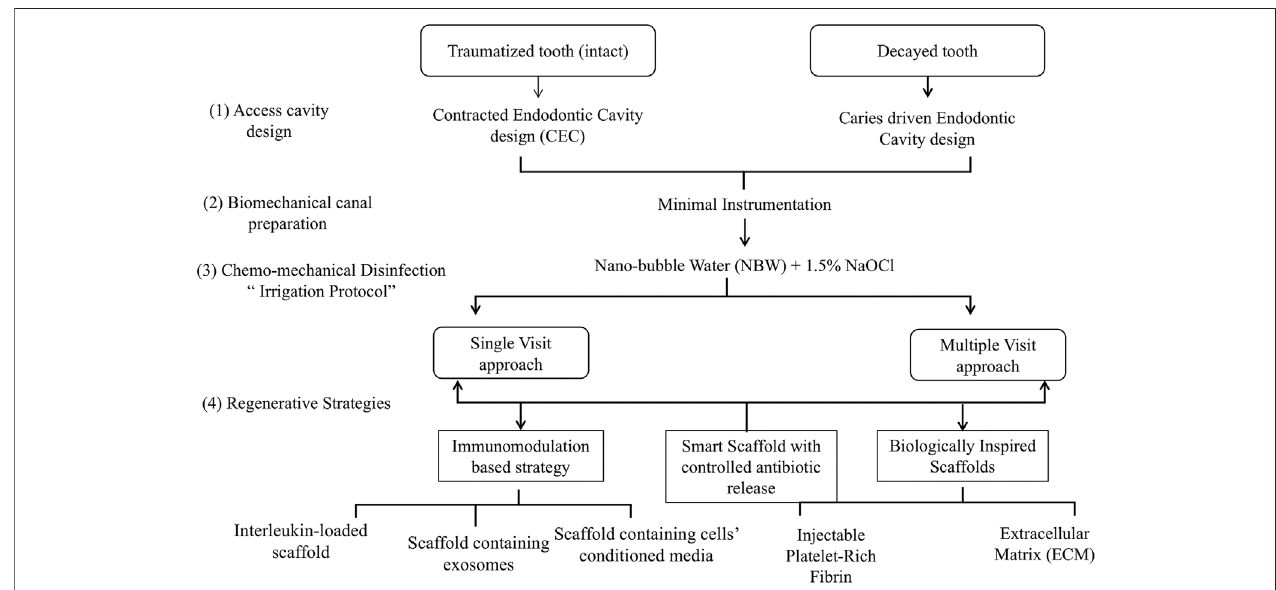
FIGURE 1 | Flow Chart representing possible strategies to implement for “ minimally invasive regenerative endodontic procedures (MIREPs). ”